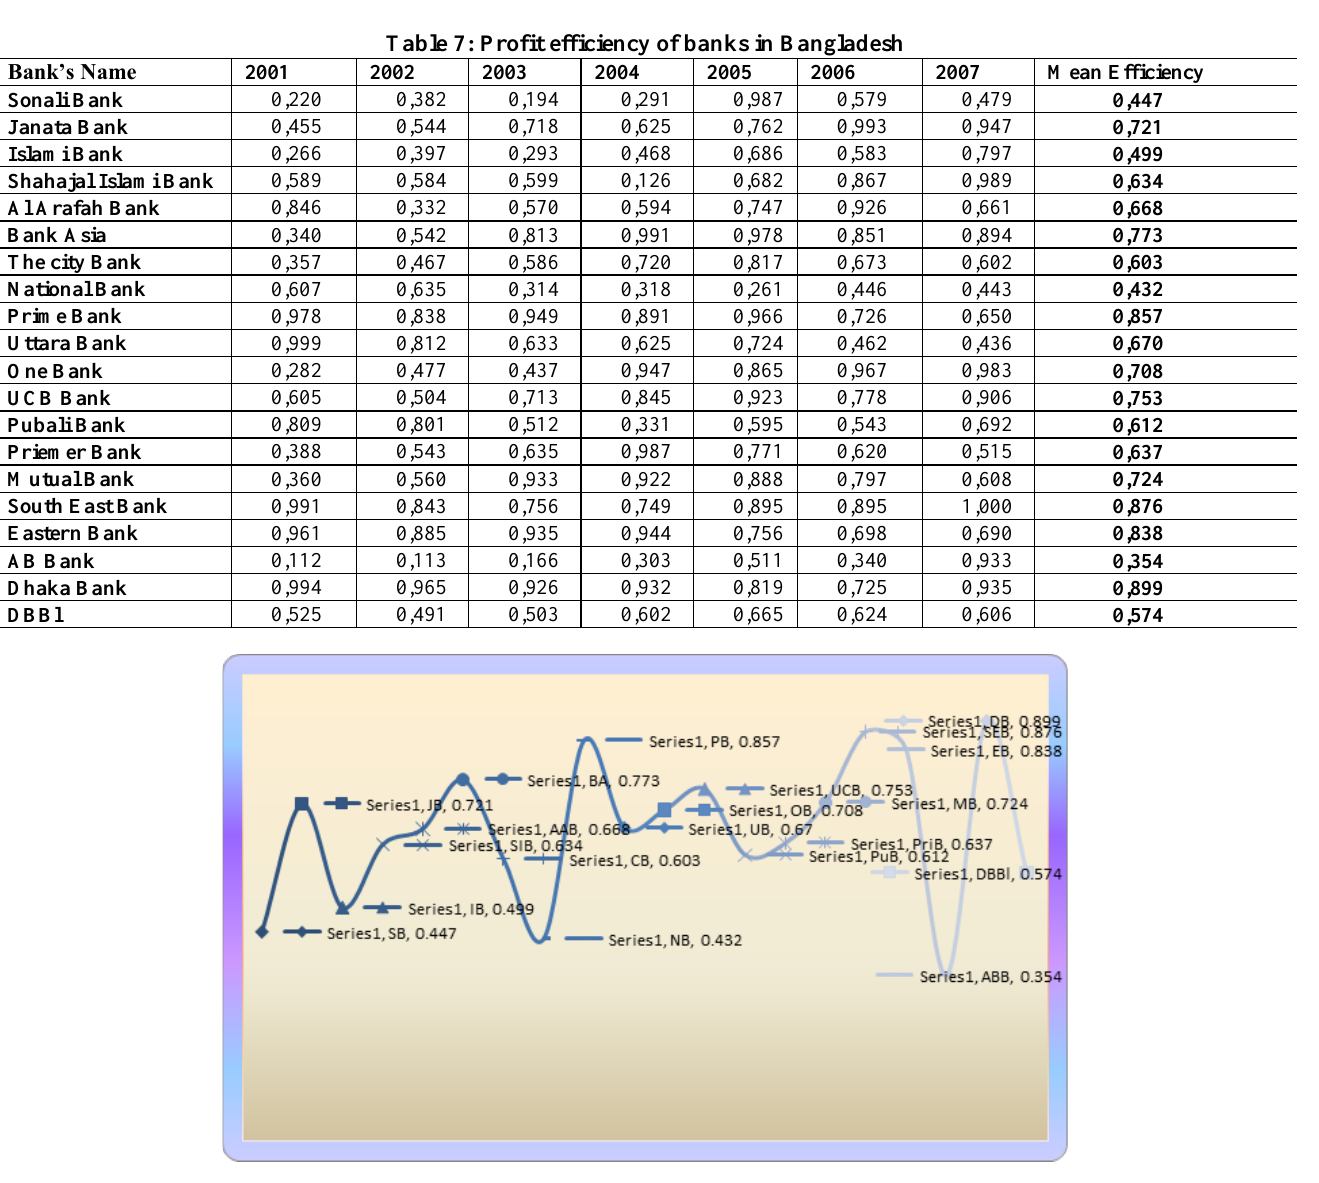
Figure 3: Bank-wise profit mean efficiency in